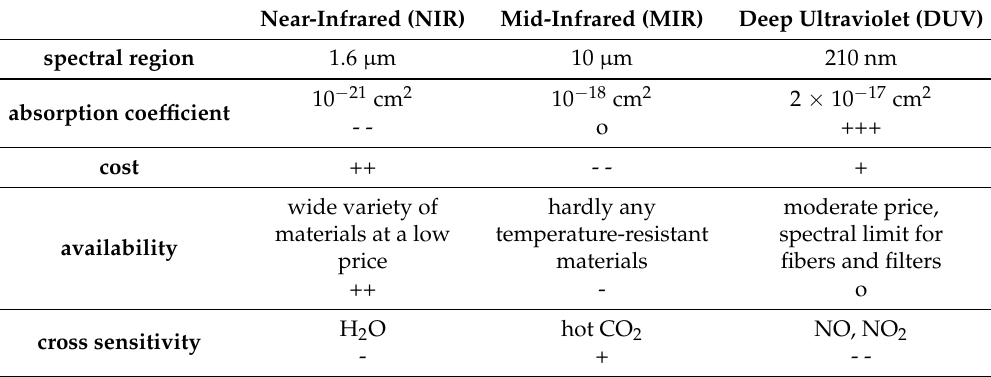
Table 1. Properties of the three most sensitive ammonia absorption spectral